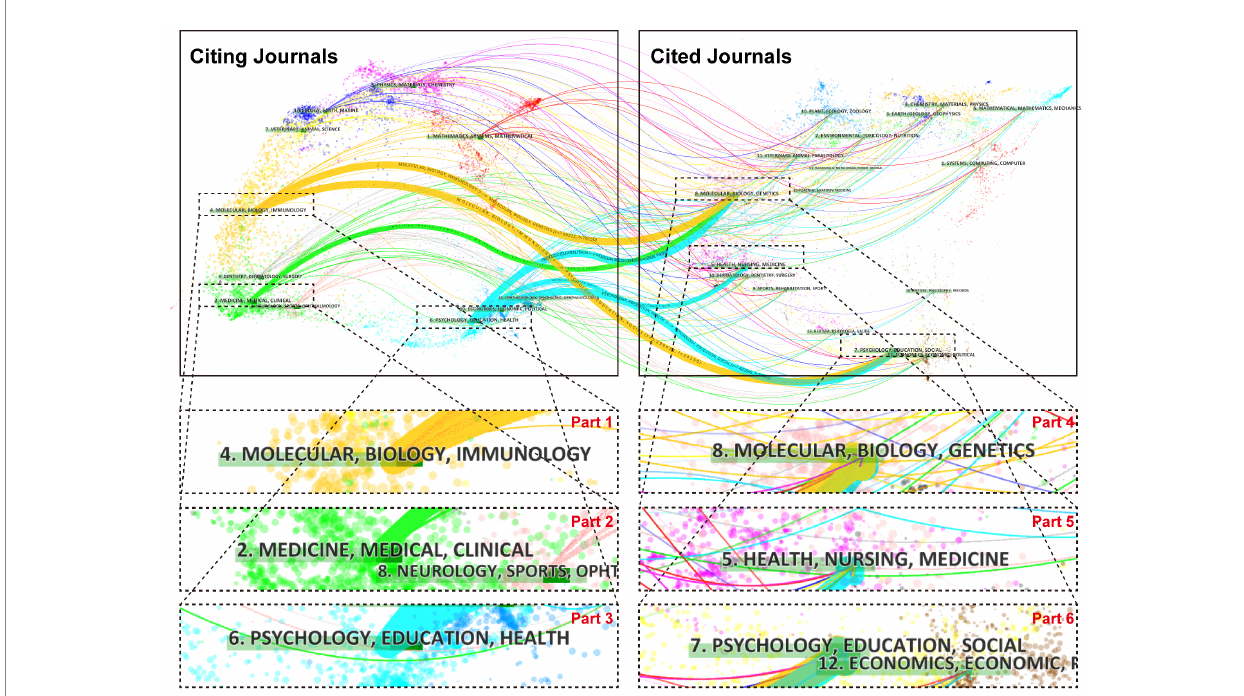
FIGURE 4 A dual-map overlay of journals that published work related to ASD. A presentation of citation paths at a disciplinary level on a dual-map overlay. The width of the paths is proportional to the z-score-scale citation frequency. The labels on the map represent the research subjects covered by the journals, and the wavy curve connects the citing articles on the left side of the map and the cited articles on the right side of the map.